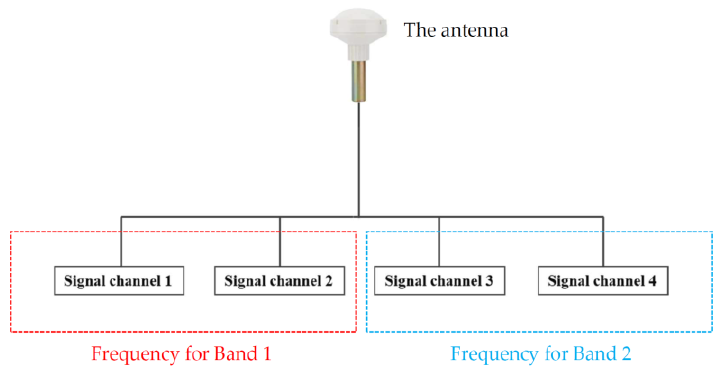
Figure 2. Diagram of the zero-baseline experiment in this study.